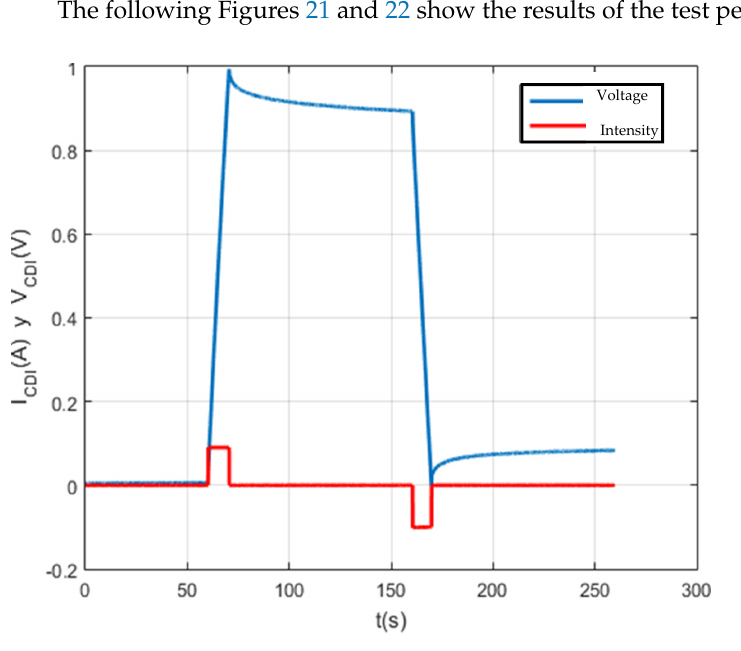
Figure 21 Charging and discharging test characterizing a 1 F supercapacitor. Figure 21. Charging and discharging test characterizing a 1 F